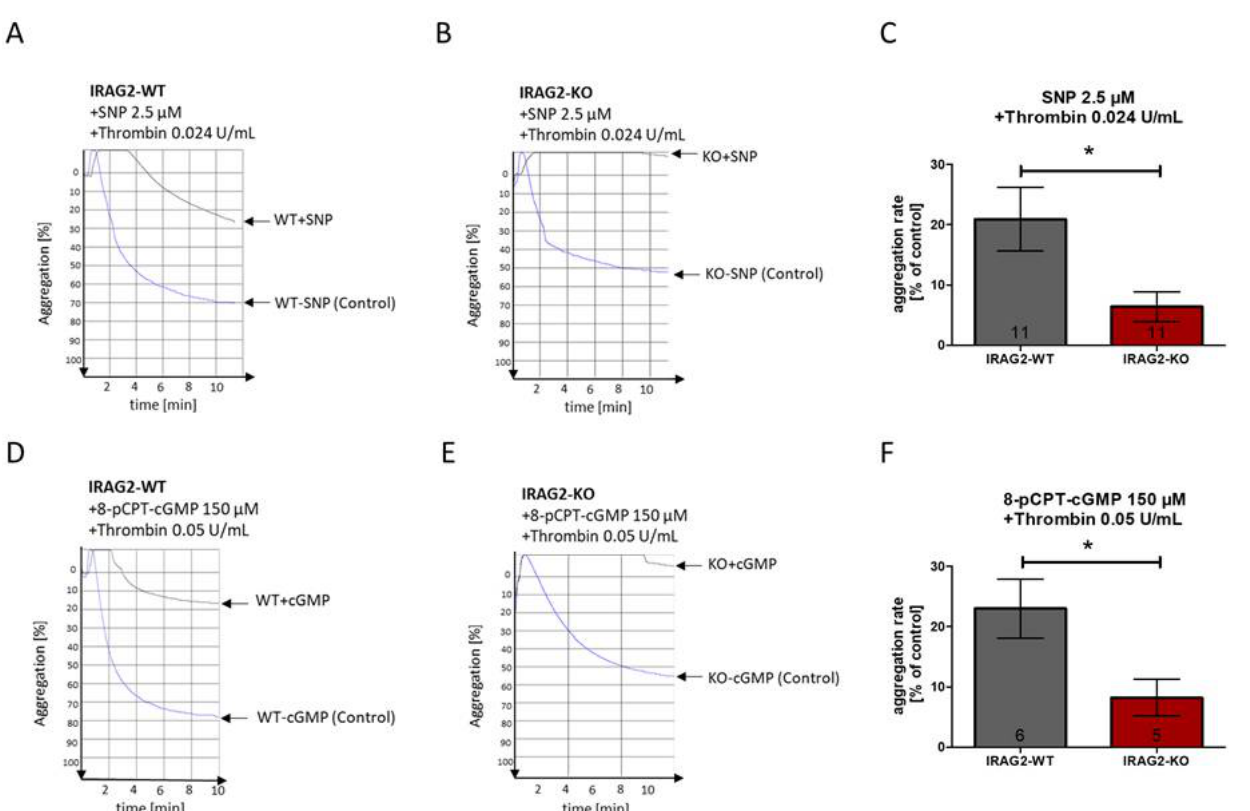
Figure 5. NO/cGMP-dependent inhibition of platelet aggregation in platelets from IRAG2-WT and IRAG2-KO mice. Aggregation rate was calculated as maximal slope and aggregation rate with inhibitor was calculated as % of control (control: aggregation rate without inhibitor). ( A , B ) Representa- tive images of inhibition of platelet aggregation in platelets from IRAG2-WT mice ( A ) and IRAG2-KO mice ( B ) using sodium nitroprusside (SNP) 2.5 µM as an inhibitor and thrombin 0.024 U/mL to evoke platelet aggregation. ( C ) Statistical evaluation of platelet inhibition with SNP 2.5 µM revealed reduced aggregation rate as % of control in platelets from IRAG2-KO mice compared to IRAG2-WT mice. ( D , E ) Representative images of platelet inhibition in platelets from IRAG2-WT mice ( D ) and IRAG2-KO mice ( E ) with 8-pCPT-cGMP 150 µM as an inhibitor of platelet aggregation and thrombin 0.05 U/mL as an agonist of aggregation. ( F ) Statistical evaluation showed a lower aggregation rate as % of control in platelets from IRAG2-KO mice compared to platelets from IRAG2-WT mice. For each aggregation 1.0 × 10 8 platelets/mL were used. Number of experiments (number of mice) are shown in the graphs and mean ± SEM are indicated by bars. Significant differ- ences are shown by (*) ( p < 0.05).